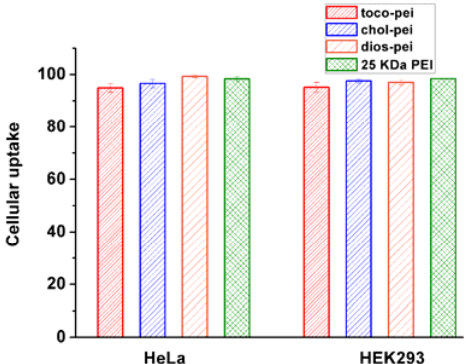
Figure 11. Cellular uptake by flow cytometry analysis: lipopolymer/DNA polyplexes at optimal transfection w / w ratios toward HeLa and HEK293 cells with a serum-free medium; 25-kDa PEI was used for comparison (mean ± SD, n = 3).